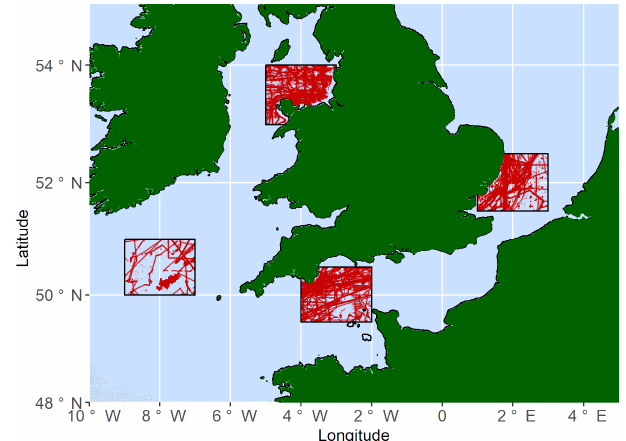
Figure 7. Illustration of “near-surface” (0–5m) data coverage for four ICES rectangle groups: (a) Liverpool Bay, (b) Celtic Sea, (c) Brixham, and (d) the Thames area. Plotted point intensity re- flects data